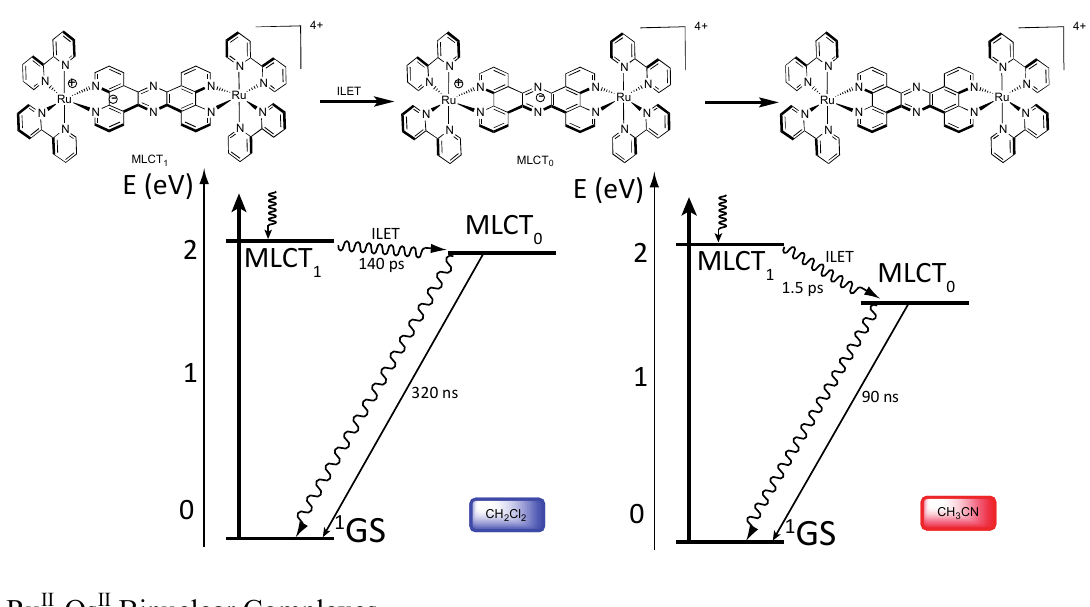
Figure 27. Photophysical mechanism for the Ru II -Ru II TPPHZ binuclear complex in CH Cl ( left ) and CH CN ( right ) 2 2 3